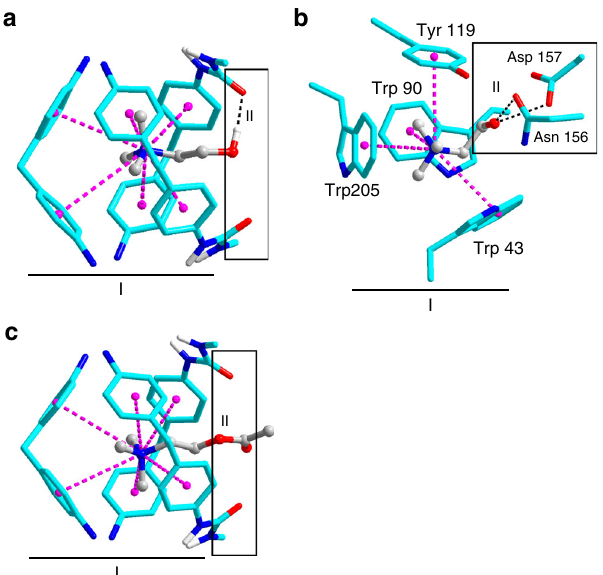
Fig. 7 Comparison of the binding modes for Ch + and Ach + in host 2 and ChoX. a DFT-optimized structure of Ch + ⊂ 2 . b Crystal structure of Ch + ⊂ ChoX (Protein Data Bank code 2reg) 2 . c DFT-optimized structure of ACh + ⊂ 2 . Binding sites are labeled as I and II, cation – π , and hydrogen bonding interactions are labeled as purple-dashed line and black-dashed line,